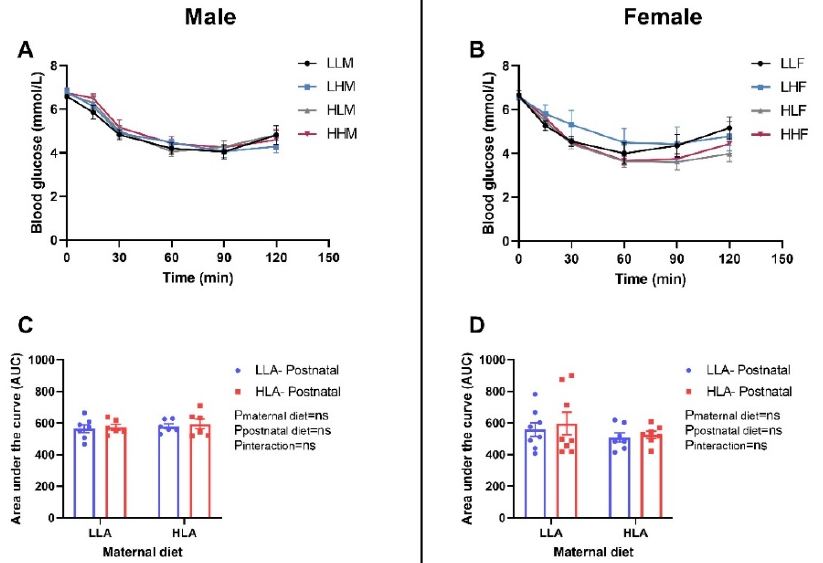
Figure 4. Effect of a maternal and postnatal diet high in linoleic acid on insulin tolerance in adult offspring. Data are presented as mean ± standard error of the mean (SEM). The area under the curve (AUC) was calculated using GraphPad Prism. Two-way ANOVA was performed for statistical analysis with maternal diet and postnatal diet as two factors. n = 6–8. LLA: low linoleic acid; HLA: high linoleic acid; PN: postnatal; ITT: insulin tolerance test. A : Blood glucose male; B : Blood glucose female; C : Area under the curve male; D : Area under the curve female.